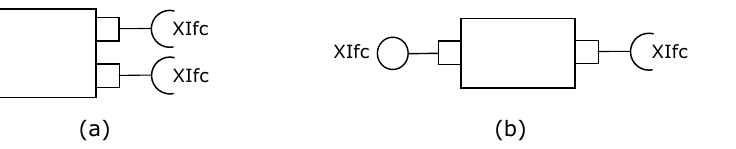
Figure 15. Cases searched in real-life projects: ( a ) Case 1: a class having more than one port that requires the same interface. ( b ) Case 2: a class that provides and requires the same interface at multiple ports.